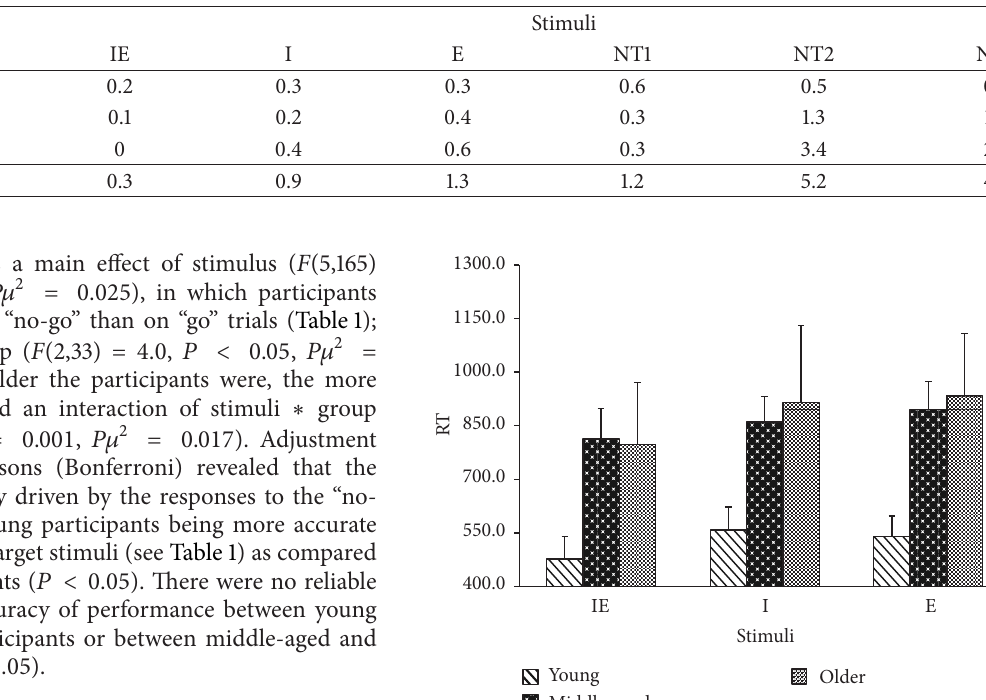
Table 1: The mean percentage of errors for redundant targets (IE), the identity target (I), the emotional expression target (E), and the 3 nontarget faces (NTs) for groups of young, middle-aged, and older participants.